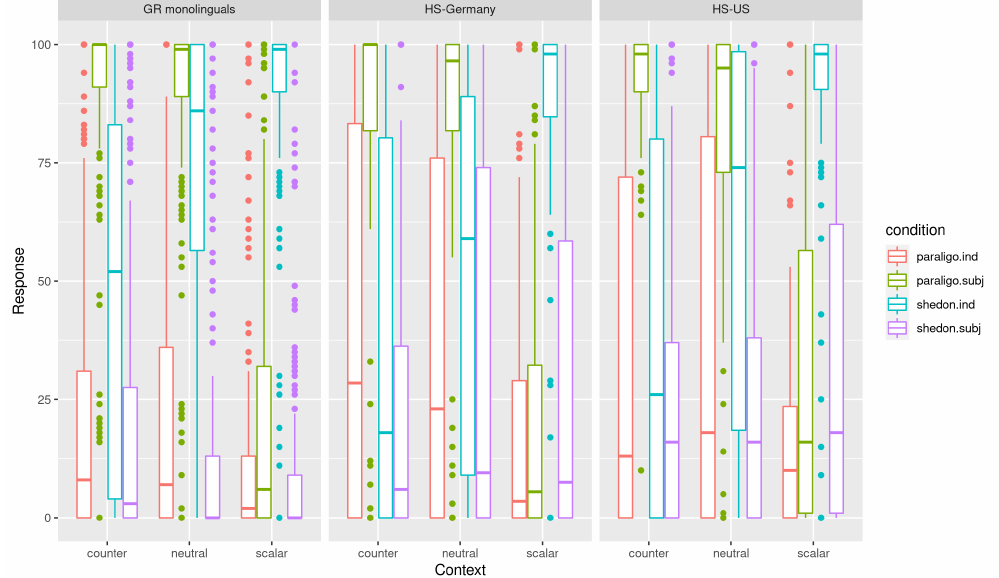
Figure 3. The figure shows Responses to sentences in the study grouped into boxplots by Context and Condition variables. These two variables structured the design of the study and determined how items were presented. Each subplot shows the results for one participant group as indicated by the title at the top of each